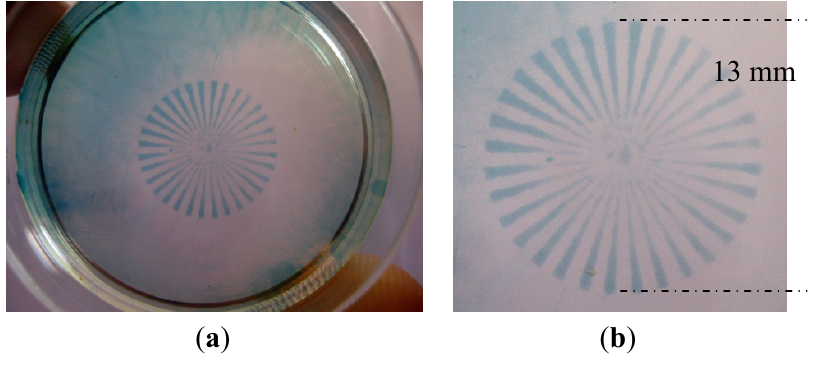
Figure 5. ( a ) Patterned stained iron(III) cross-linked alginate hydrogel after irradiation and washing; ( b ) Enlarged image of the patterned stained